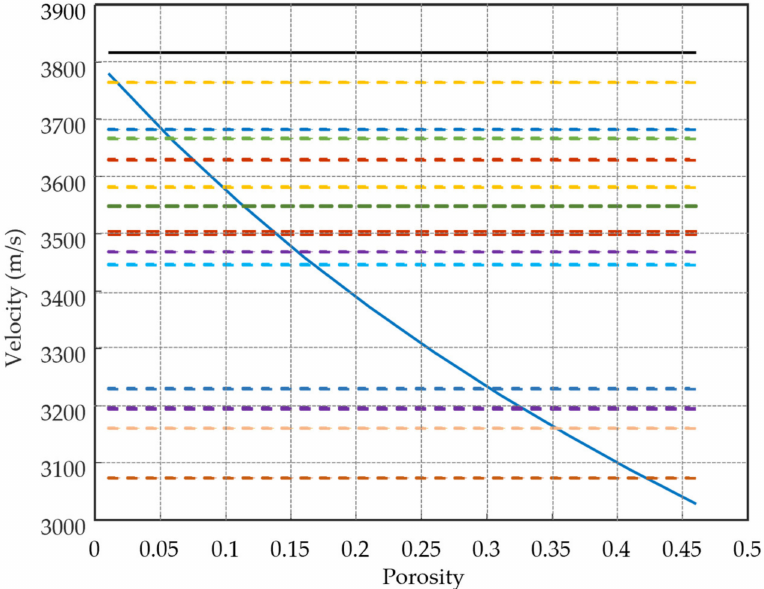
Figure 18. Comparison of theoretical ( solid lines ) and measured ( dashed lines ) ultrasonic velocities in porous ice drop experiments. The theoretical values were provided by the micromechanical model for increasing porosity. It can be observed that the velocities obtained in most experiments correspond to porosities in the 5% to 16% range. The expected average porosity of 10.2%, which corresponds to the gas-to-liquid volume in sparkling water, falls within these values. The four experiments at the bottom are anomalous, their low velocities are attributed to a poor contact of the ice drop with the transducer or cracks in the